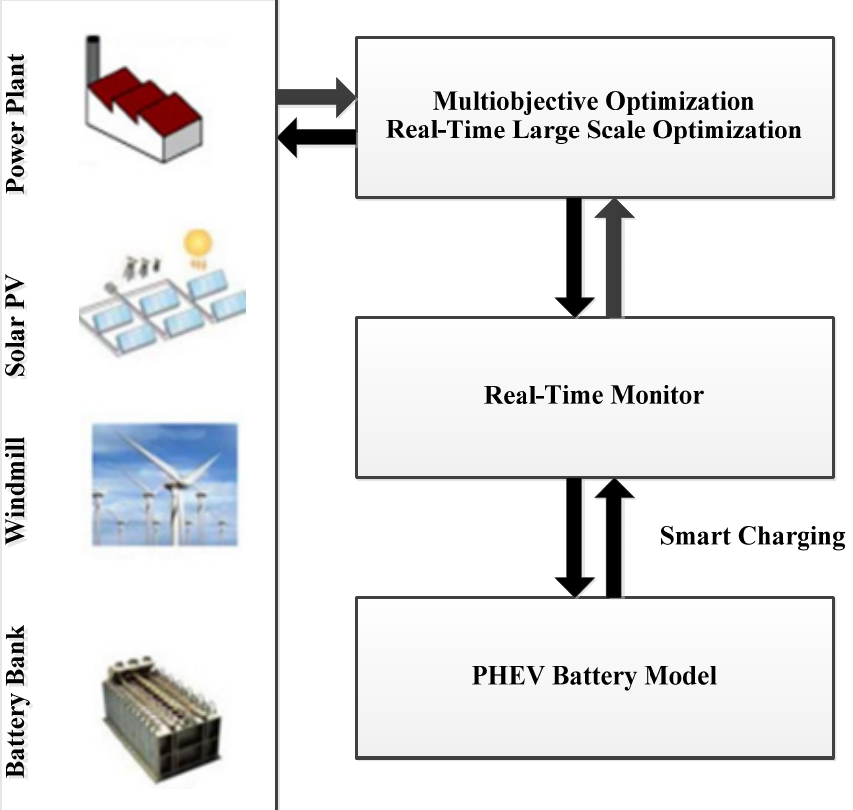
Figure 1. Large-scale PHEV charging infrastructure in a smart grid environment [14].